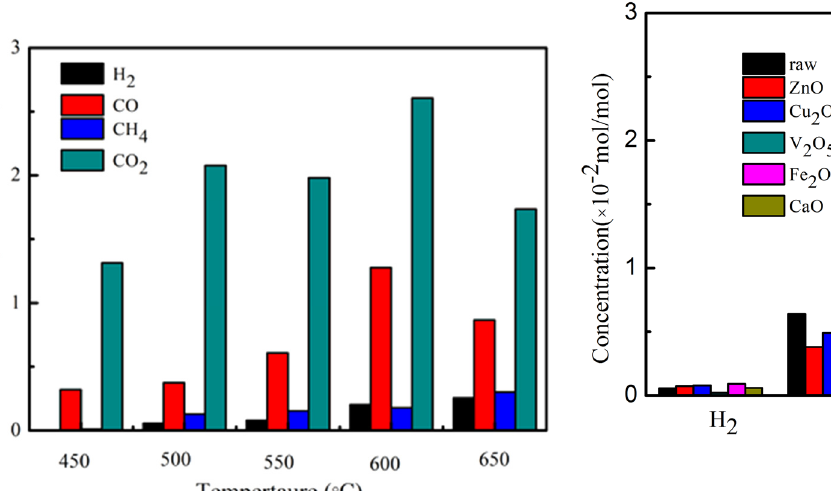
Figure 6: Gas distribution of navel orange peel with di ff erent metal